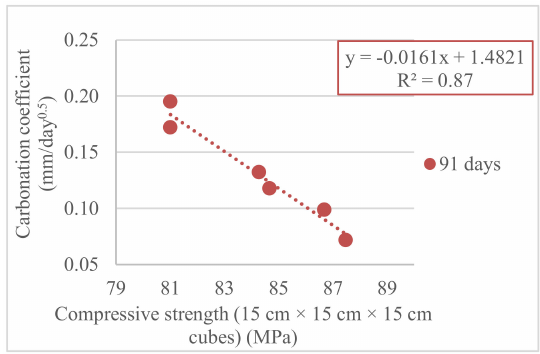
Figure 19. Relationship between the carbonation coe ffi cients and compressive strength (15 cm × 15 cm × 15 cm cubes) results at 91